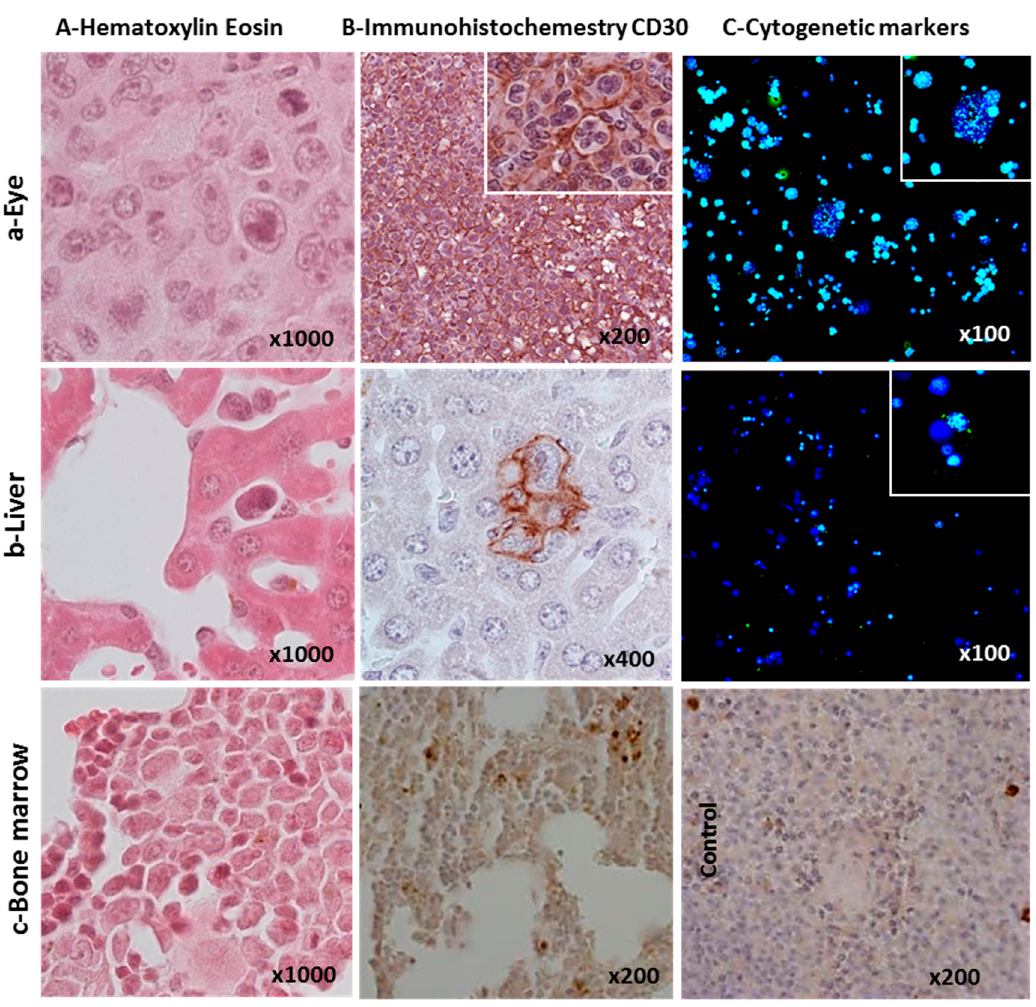
Figure 3. Organ infiltration and tumor markers identifying the L428-c subline in NOD/SCID/gamma ( − / − ) (NSG) mice. ( A ) Hematoxylin and eosin, ( B ) Immunohistochemical, and ( C ) Cytogenetic markers using human centromere probes (green) are shown. Infiltration of tumor cells in the (a) orbit/ocular tissues (site of injection), (b) the liver, and (c) bone marrow. Monkey spleen served as a positive control for CD30 staining.